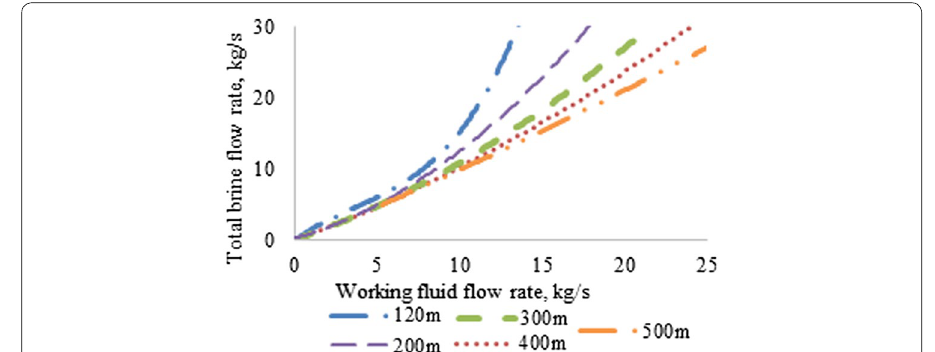
Fig. 12 Brine and working fluid flow rates change for different well